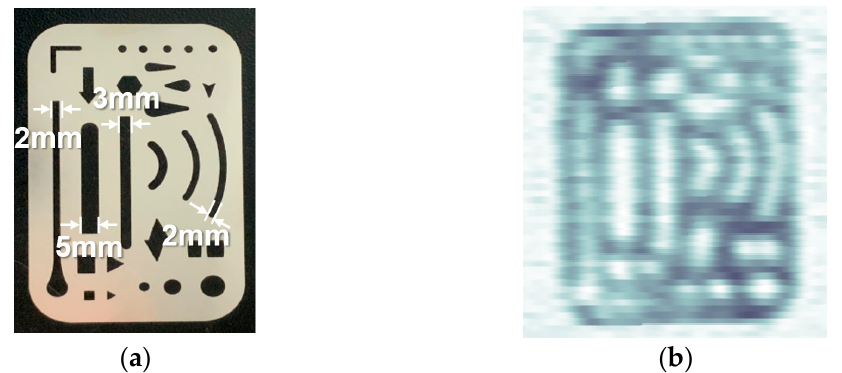
Figure 4. ( a ) Photo of the metal erasing shield. ( b ) The imaging result of the metal erasing shield.